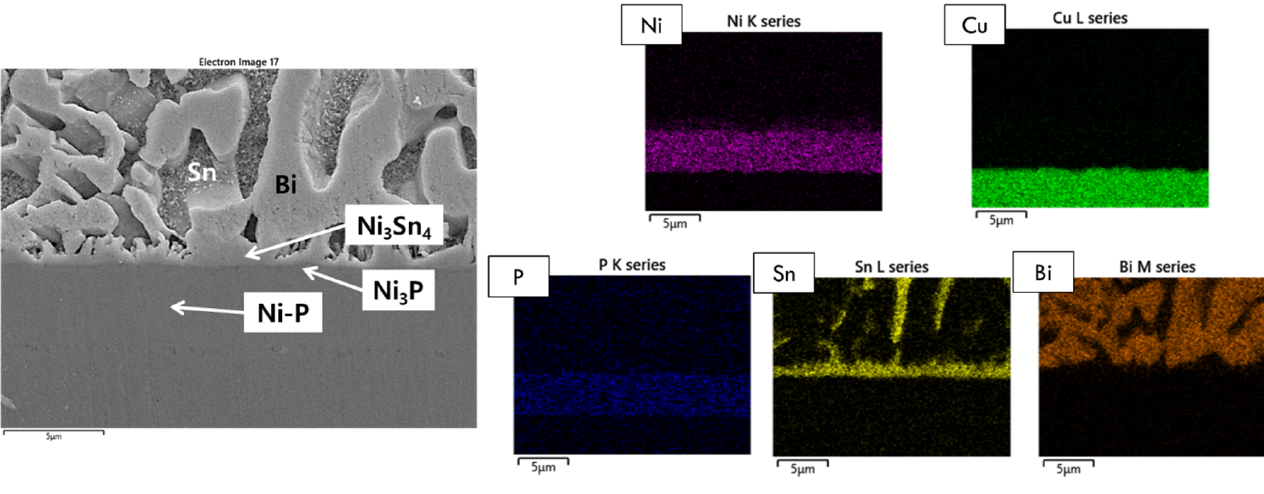
Figure 3. EDX elemental analysis of the Sn-58Bi-0.1Pt/ENIG interface after 200 h of aging.